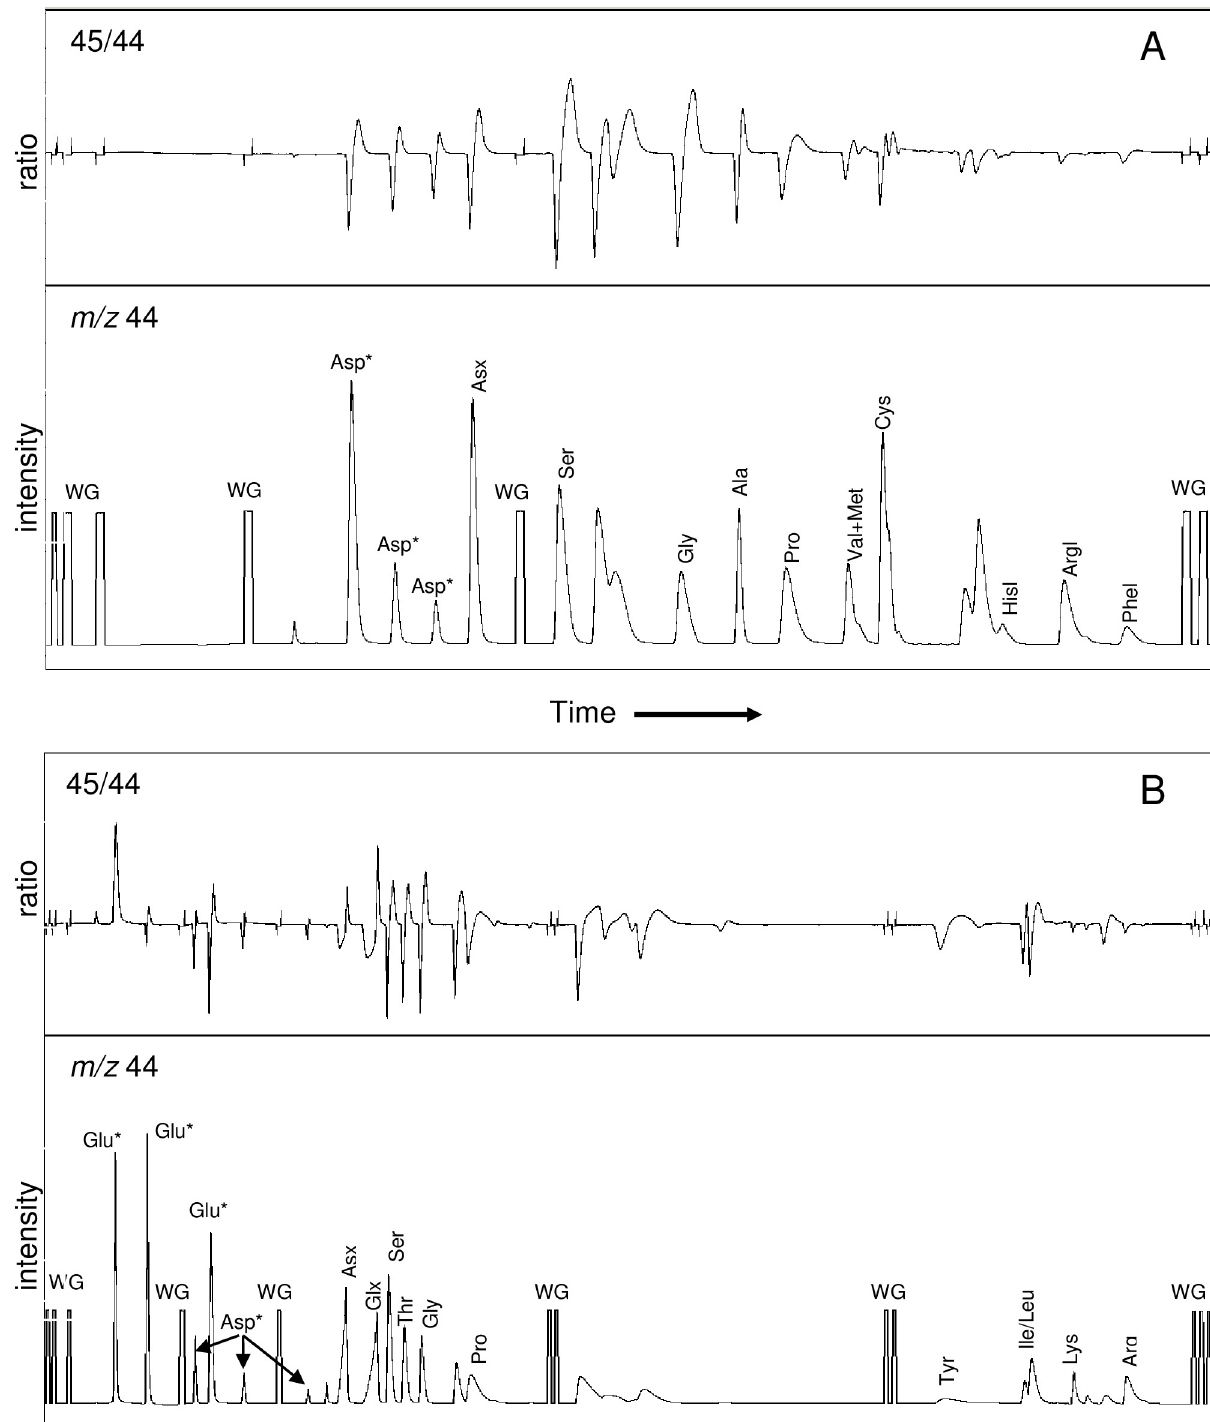
Fig 3. Representative ion chromatograms ( m/z 44) and ion ratio plots (45/44) for the PSIA analysis of a keratin hydrolysate (USGS42 Tibetan human hair) showing; (A) the short HPLC method and (B) the long HPLC method. Peaks that were integrated to calculate the final results are labelled. In both chromatograms the working gas (WG) was set to an intensity of 4000 mV and the 45/44 ratio swing for the Arg peak was typically 1.16 to 1.24. The 45/ 44 ratio swing for the Gly peak varied between the short run (typically 0.9 to 1.4) and the long run (typically 1.10 to 1.45) due to different solvent compositions and different interaction with the ionic stationary